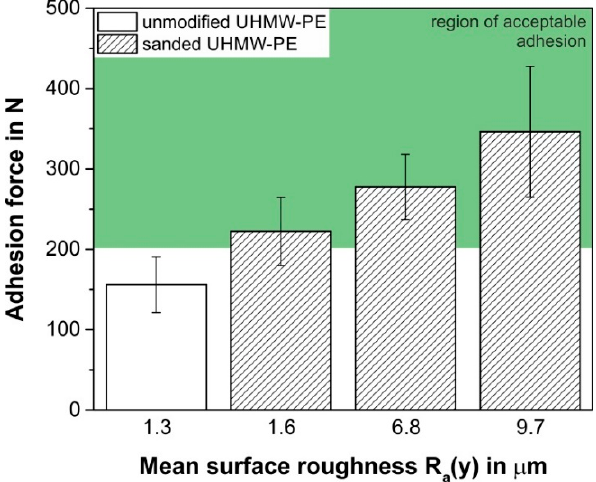
Figure 8. Adhesion forces of the PP-composite as a function of the arithmetic mean surface roughness of the UHMW-PE build platform. All results were obtained under optimised processing conditions, which represent the maximum of the regression function plot of Figure 5d.